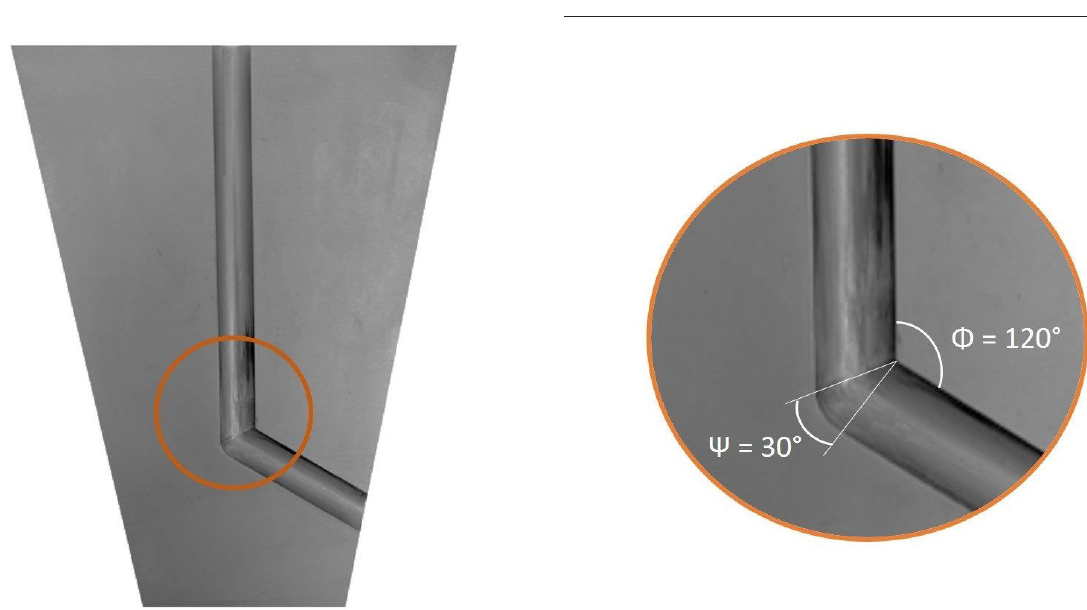
Figure 1. Self-designed split ECAP die with channel angles of Ф = 120° and ψ =